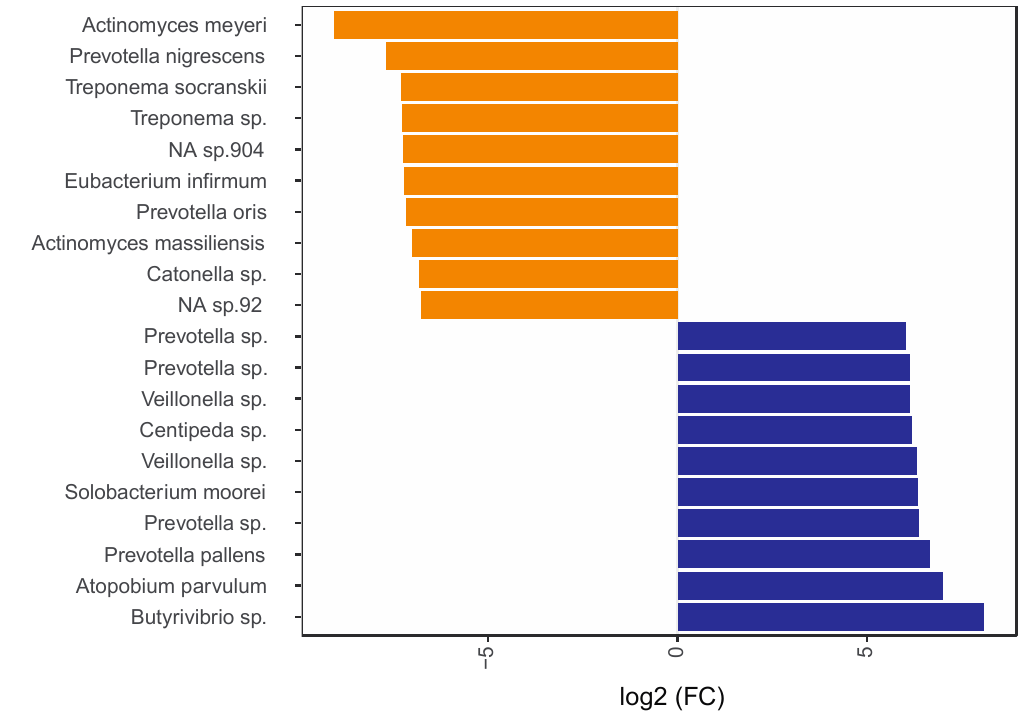
Figure 2. Most highly di ff erentially abundant bacterial species in plaque compared to saliva samples. The graph demonstrates log2 Fold Change (FC) for the ten most enriched as well as the ten most depleted bacteria in plaque compared to saliva from patients with RA irrespective of periodontitis. Negative log2 FC indicates higher abundance in plaque samples (orange bars) and positive values indicate higher abundances in saliva samples (blue bars). NA, genome reference not available. The di ff erences between the groups were analysed using DESeq2 [40]. *Adjusted p value < 0.05 was considered statistically significant.